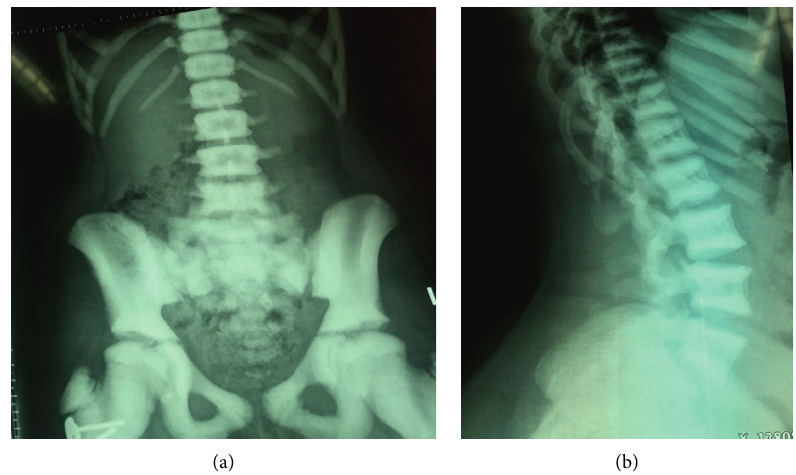
Figure 1: X-ray spine and pelvis showing dense vertebrae and pelvic bones (a), and Sandwich vertebrae